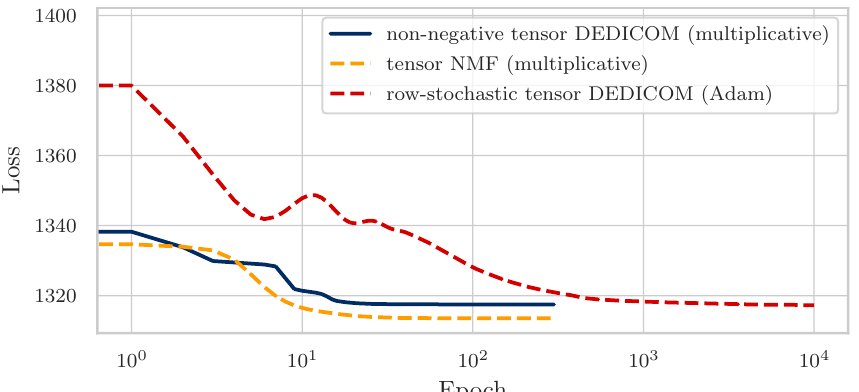
Figure 2. Reconstruction loss development during tensor factorization training. The x -axis plots the number of epochs on a logarithmic scale, the y -axis plots the corresponding reconstruction error for each